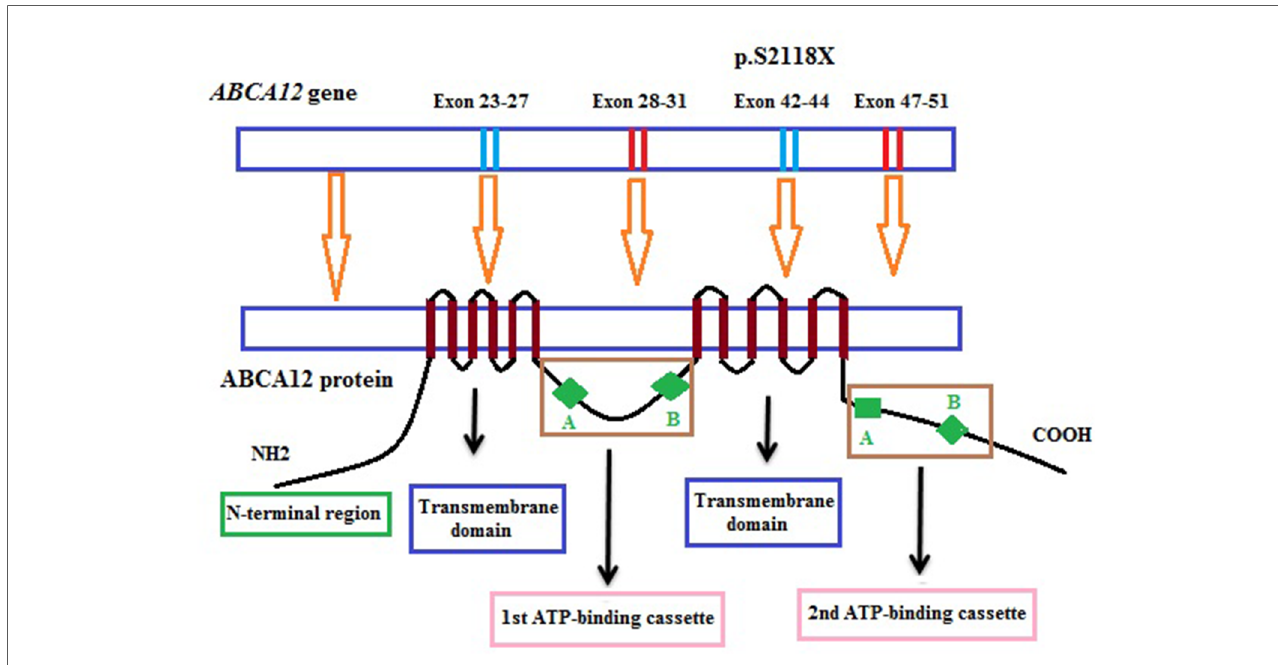
FIGURE 3 Position of the mutation in the structure model of the ABCA12 gene and ABCA12